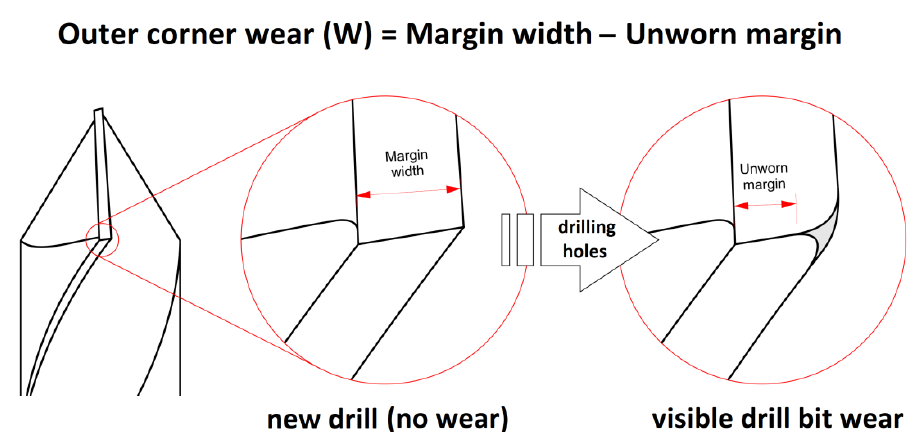
Figure 3. The way of outer corner wear (W) determination.